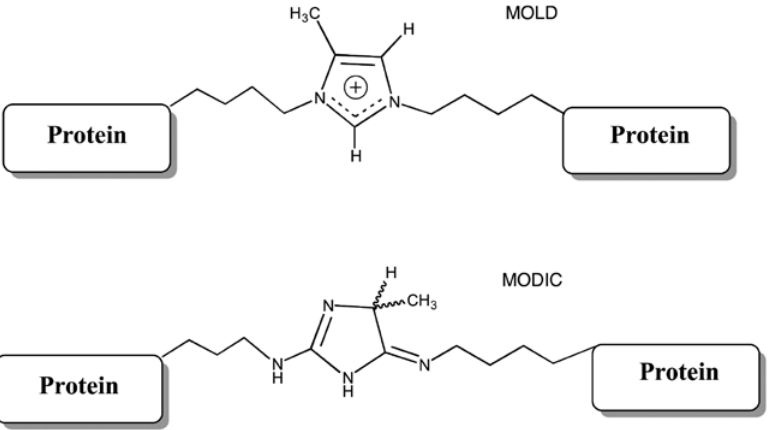
Figure 11: Chemical structures of identified protein crosslinks formed due to advanced glycation end-product reactions with